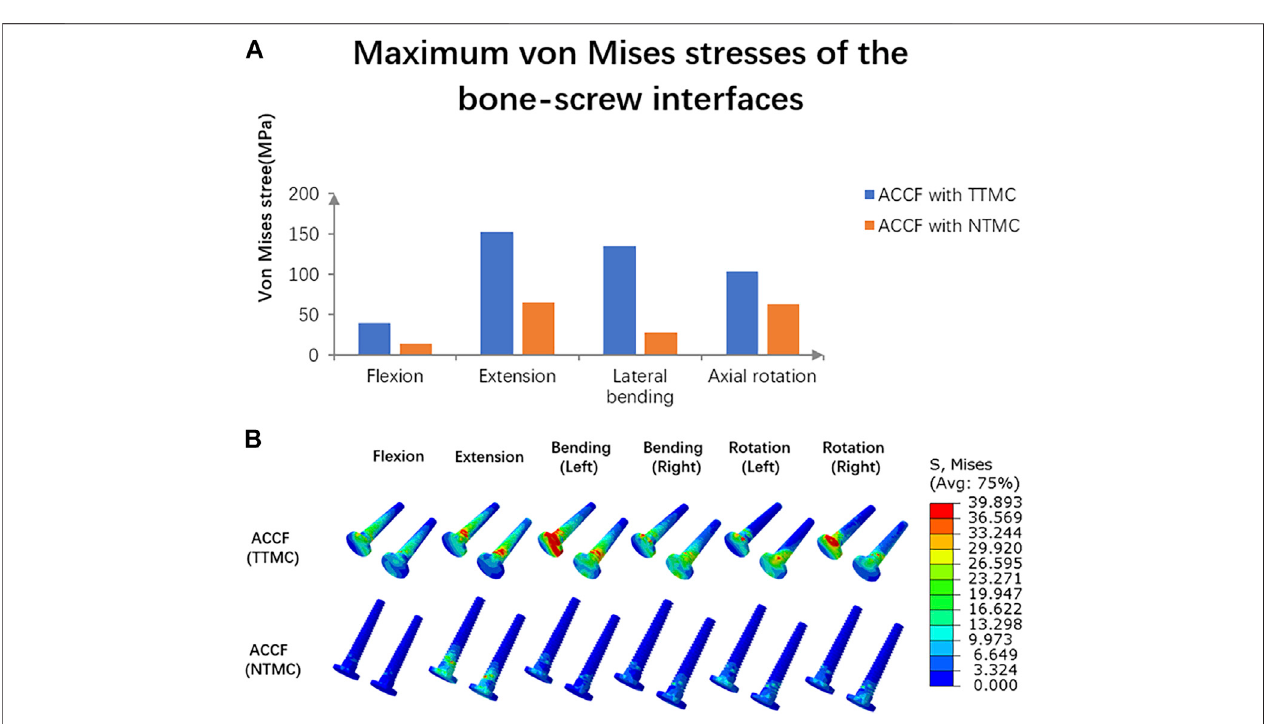
FIGURE8| (A) Comparisons ofthe maximum vonMises stressesinthe C6screw – bone interface between TTMCand NTMC models; (B) Stress cloud map ofthe C6 screw – bone interface between TTMC and NTMC models.